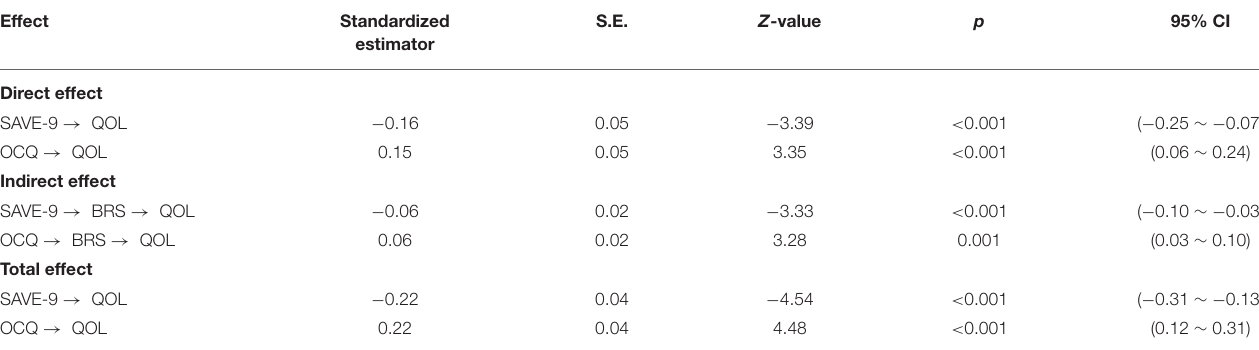
TABLE 5 | The results of direct, indirect, and total effects on mediation analysis. Effect